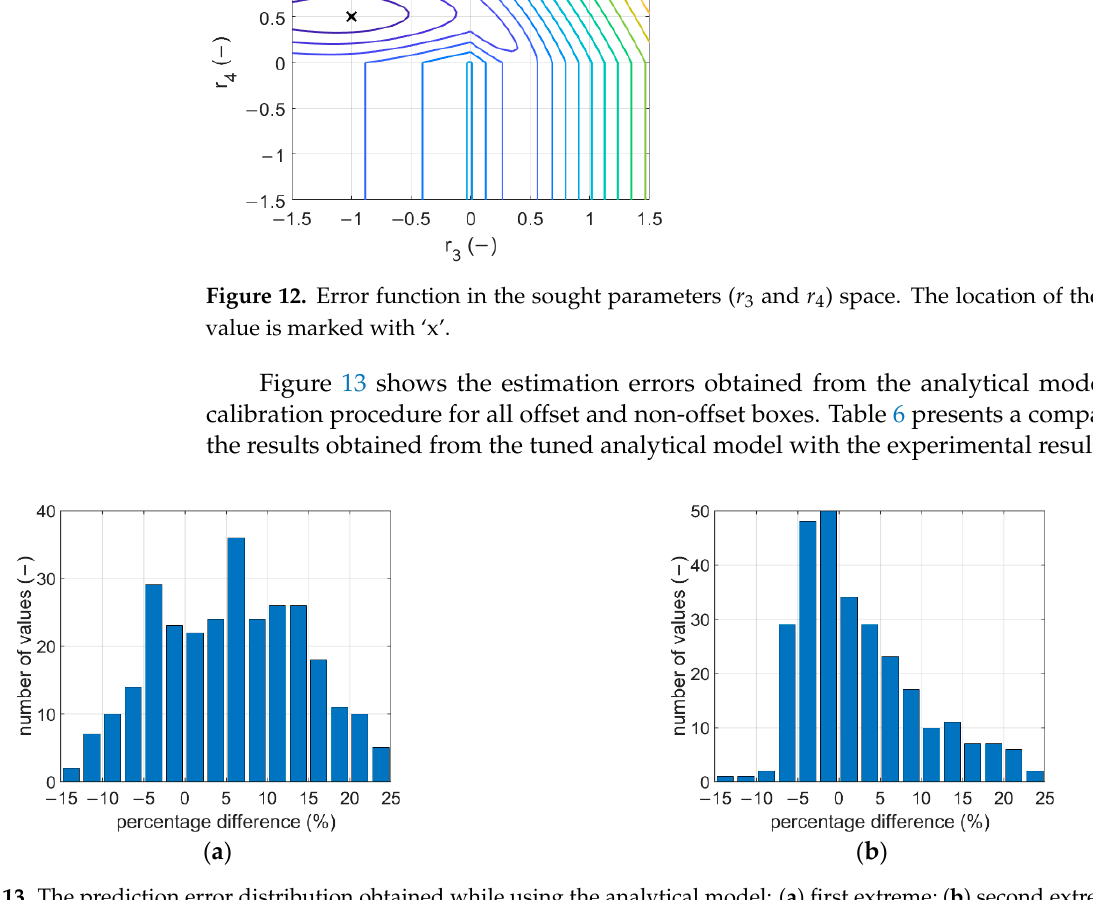
Table 6. Comparison of measured and analytically determined BCT values for various corrugated cardboard packaging.